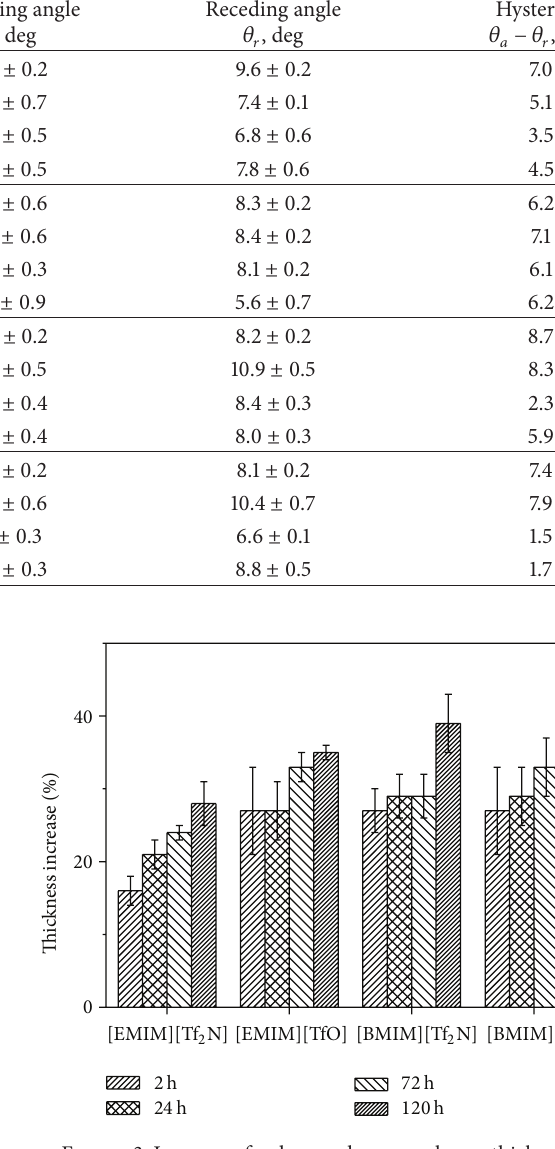
Figure 3: Increase of polypropylene membrane